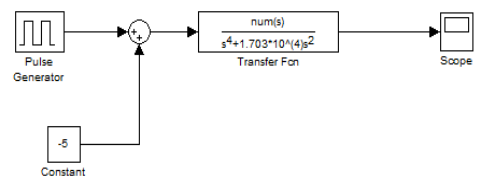
Fig 5. The system with the optimal controller G(s).